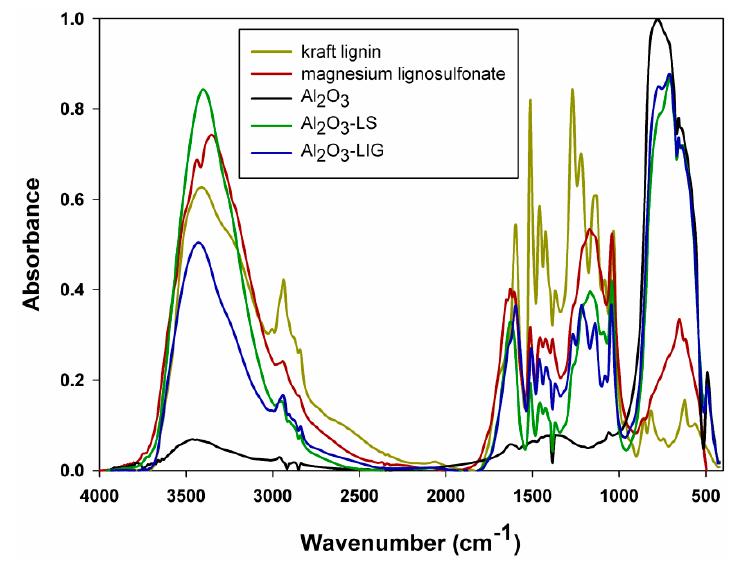
Figure 1. Fourier transform infrared spectroscopy (FTIR) spectra of Al 2 O 3 , lignin, lignosulfonate and inorganic-organic hybrid materials.